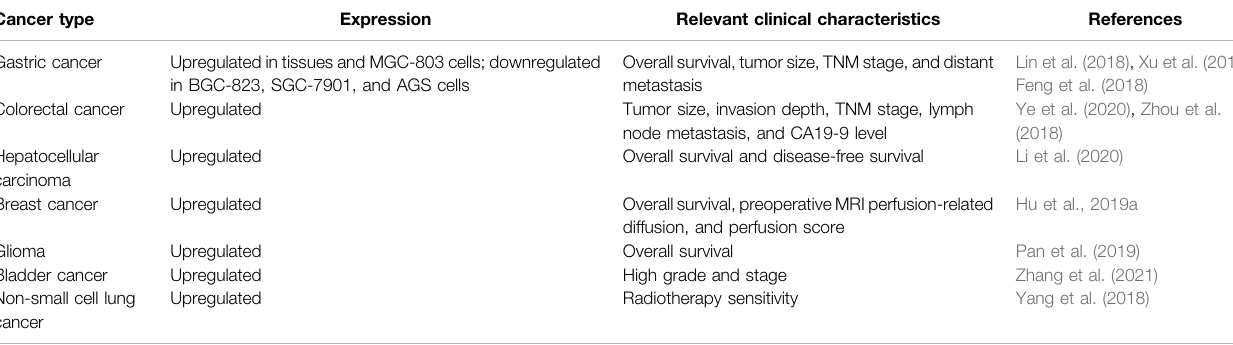
TABLE 1 | GACAT3 expression and association with clinicopathological features of human